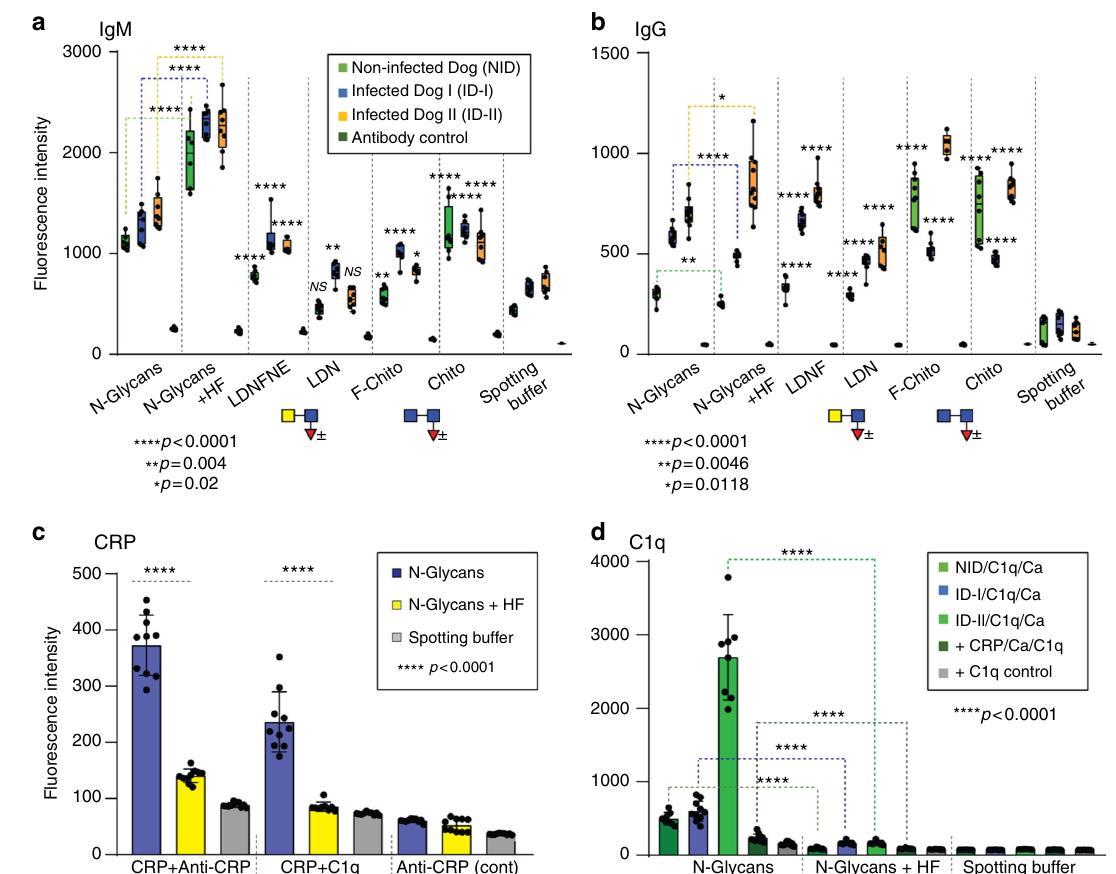
Fig. 10 Binding of dog antibodies and C-reactive protein to D. immitis N-glycans. a , b The binding of IgM and IgG antibodies in three different dog sera (1:250 diluted; non-infected dog, infected dog I and infected dog II) were tested toward natural AEAB-labelled Diro fi laria N-glycans before and after hydro fl uoric acid treatment, as well as reference 6-(5-aminopentanamido)- N -(2-[2-[oligosaccharyl- N -methoxyamino]ethoxy)ethyl]-2-naphthamides (see Supplementary Figure 23), which resemble selected terminal carbohydrate modi fi cations of D. immitis glycans, i.e. fucosylated LacdiNAc (LDNF), LacdiNAc (LDN), fucosylated chitobiose (F-chito) and chitobiose (chito; see also symbolic depictions). IgM binding toward the HF-treated glycan pool was stronger than to the natural glycan pool and was also signi fi cant towards LDNF, chitobiose and F-chito; the pattern of IgG binding was more variable, but was highest towards N-glycans and LDNF for infected dogs. c The binding of human pentraxin C-reactive protein (5 µ g/ml CRP; detected either with anti-CRP or with C1q/anti-C1q) was examined by probing the AEAB-labelled N-glycan pool (before or after hydro fl uoric acid treatment) on NHS-modi fi ed glass slides as compared to relevant negative controls (spotting buffer only or anti-CRP alone); the binding of C-reactive protein decreased after chemical removal of phosphorylcholine. d The binding of exogenous complement C1q (10 µ g/ml) in the presence of Ca(II) ions (5 mM) toward natural dog CRP interacting with Diro fi laria N-glycans was also tested using the three different sera (1:250 diluted). The strongest response was detected for the infected dog serum II (ID-II) compared to the other dog sera (control serum NID or infected dog ID-I) or the controls with no dog sera ( + CRP/C1q or + C1q). The presented data are typical of the three experiments performed per binding combination and are based on uncorrected fl uorescence values with standard deviations (mean of 10 spots); signi fi cance levels (analysed unpaired two-tailed parametric t -test at α 0.05) are shown by either dashed lines or asterisks. For further array- related data, including the HPLC chromatograms and example MS/MS of AEAB-labelled glycans, data on binding of CRP and TEPC 15 to sub-fractionated N-glycans and controls for CRP or C1q interactions in the presence of EDTA, refer to Supplementary Figures 18 –